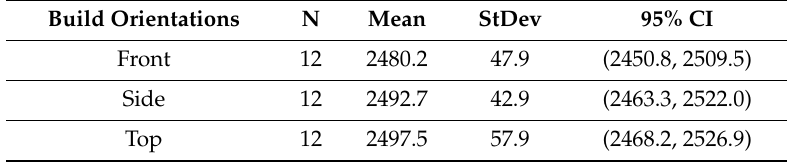
Table 13. Mean, standard deviation, and confidence intervals for E as a function of build